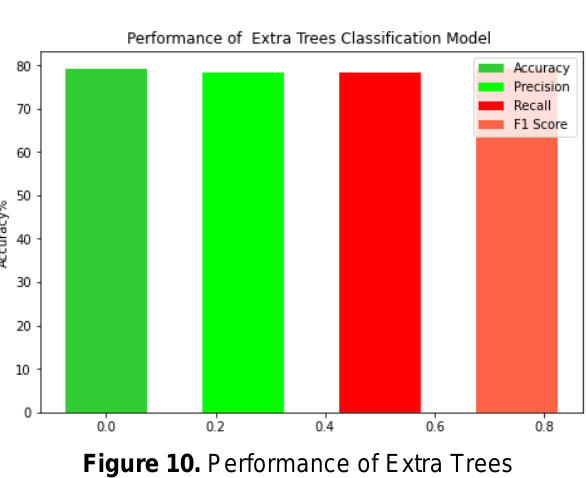
Figure 10. Performance of Extra Trees